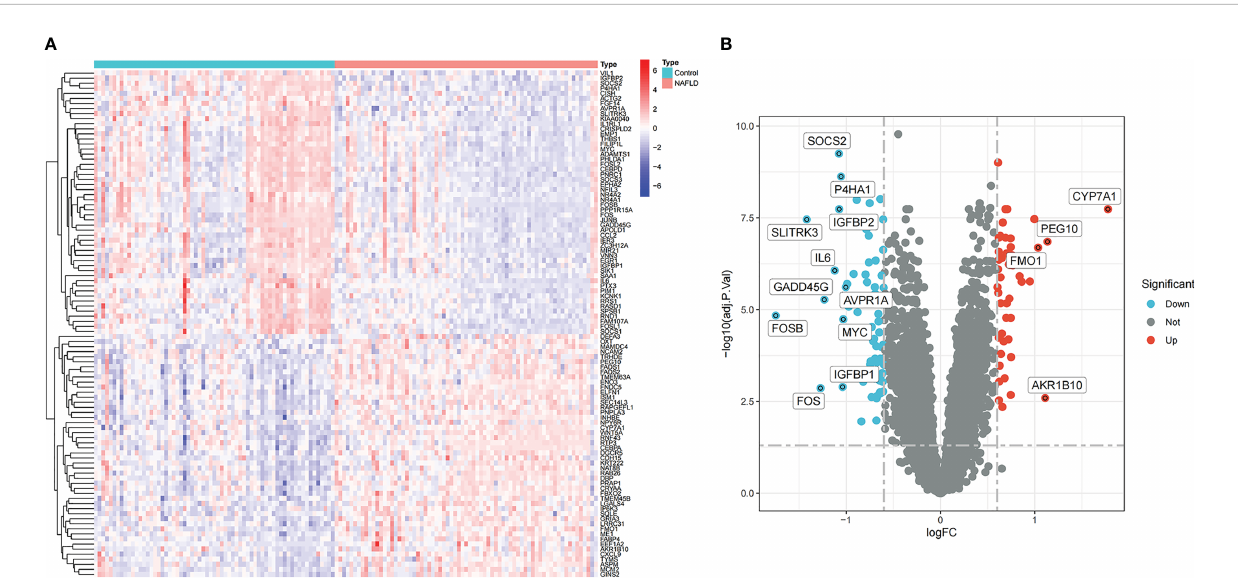
FIGURE 3 Identi fi cation of DEGs in the integrated NAFLD dataset. (A) Rows represent DEGs, and each column refers to a sample. Red and blue represent the upregulated and downregulated DEGs, respectively. (B) Red and green circles represent upregulated and downregulated DEGs, respectively.